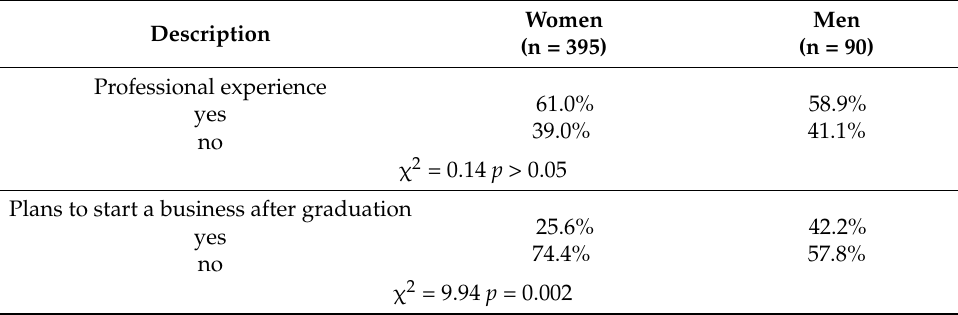
Table 3. Professional experience and plans to start a